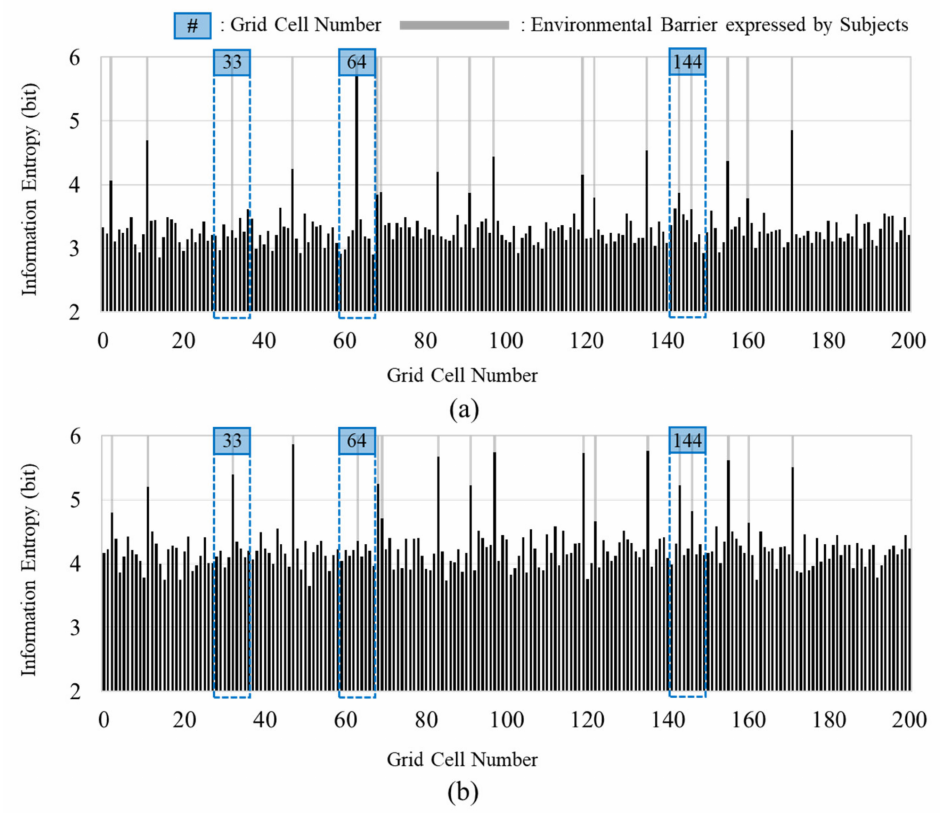
Figure 4. Information entropy by group: ( a ) Younger group; and ( b ) Elderly